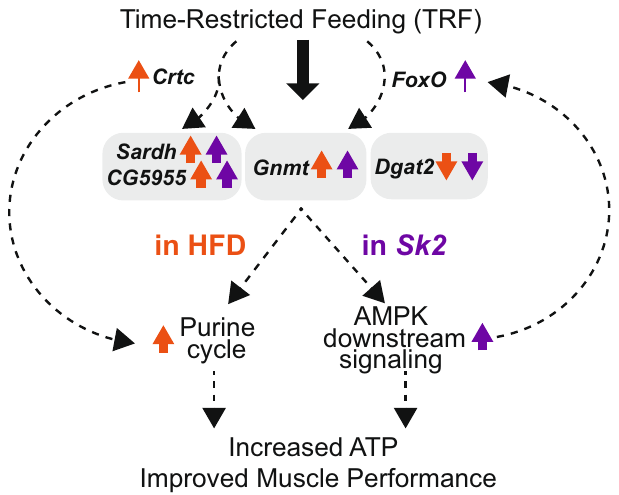
Fig. 7 | Proposed mechanism of TRF in Drosophila skeletal muscle under obe- sogenic challenges. 12 h feeding: 12 h fasting mediated TRF intervention mod- ulates common and distinct pathways in the diet- and genetic-induced obesity models. TRF induces the upregulation of Gnmt, Sardh, and CG5955 and the downregulation of Dgat2 in both HFD and Sk2 obesity models. In HFD model, TRF induces upregulation in genes and increases in metabolites related to the purine cycle. Upregulations in the gene expression of Gnmt, Sardh and purine-cycle associated genes are potentially promoted by Crtc. In Sk2 model, upregulation of genes and increases in metabolites relating to glycolysis, glycogen metabolism, tricarboxylic acid cycle (TCA), and electron transport chain (ETC) connected by AMP kinase (AMPK) signaling are observed under TRF. Upregulation in the gene expressionofGnmtispotentiallypromotedbyFoxO,whileactivationofAMPKmay sustain the activation of FOXO. TRF-mediated activation of the purine cycle and AMPK signaling result in higher ATP levels which potentially lead to improved muscle performance in obesity